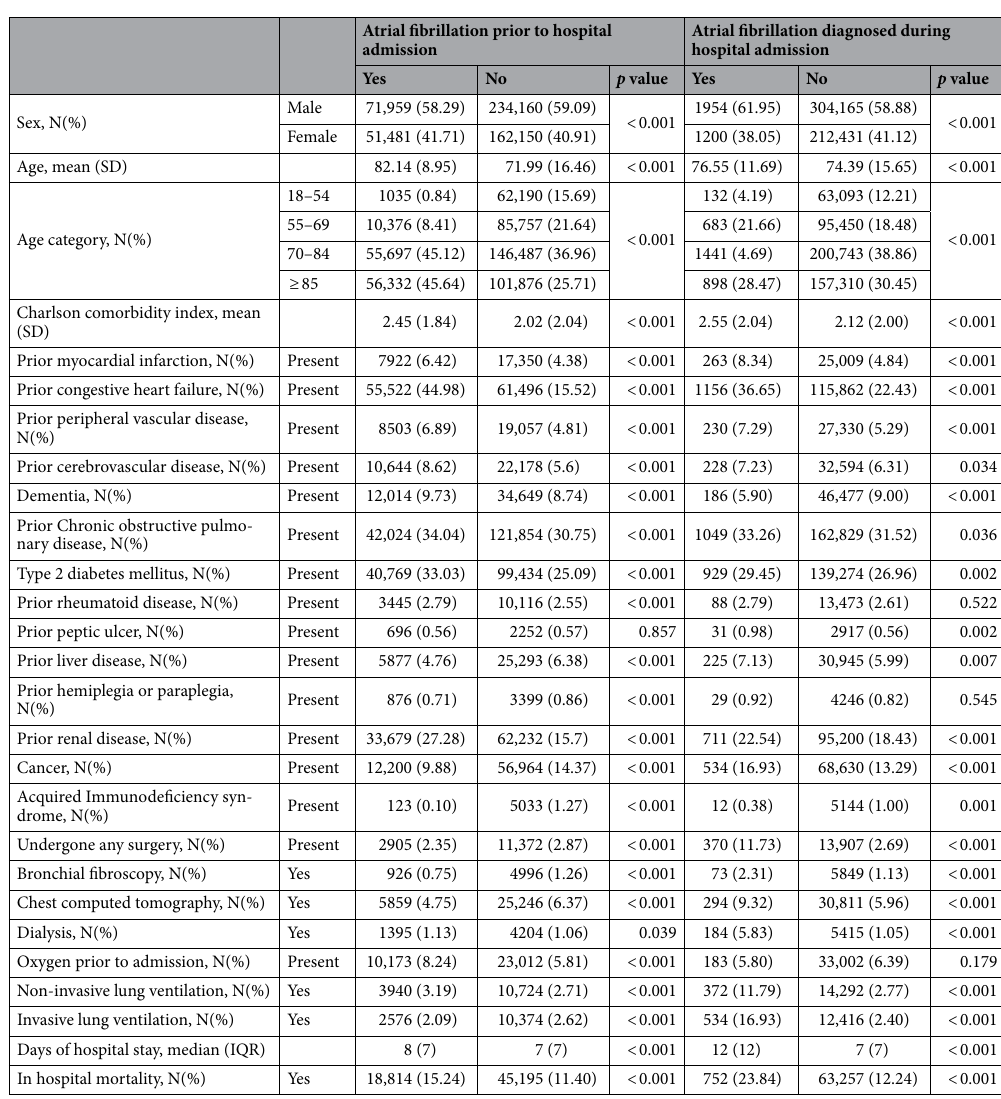
Table 1. Clinical characteristics, and in-hospital outcomes of patients hospitalized with community-acquired pneumonia in Spain from 2016 to 2019 according to atrial fibrillation prior to hospital admission, and to atrial fibrillation diagnosed during hospital